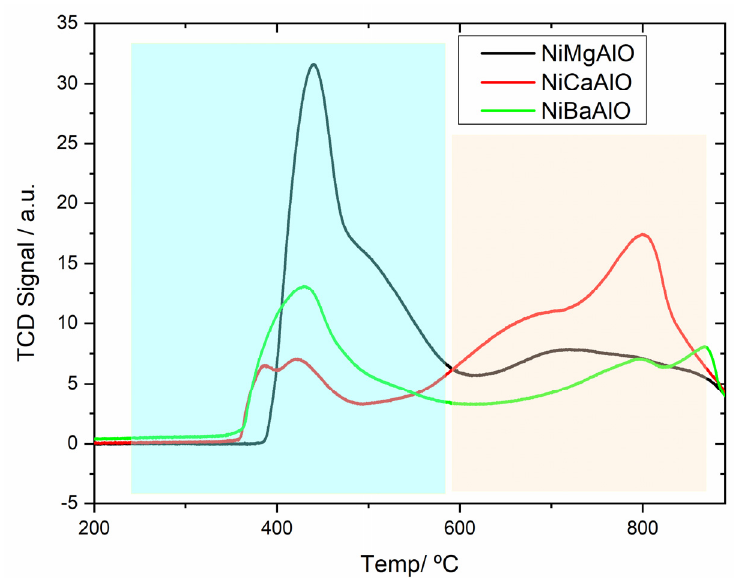
Figure 4. Temperature programmed reduction (TPR) profiles of the NiBaAlO, NiMgAlO, and NiCaAlO samples. Blue and pink windows reflect the two temperature ranges associated with the reduction processes described in the text.